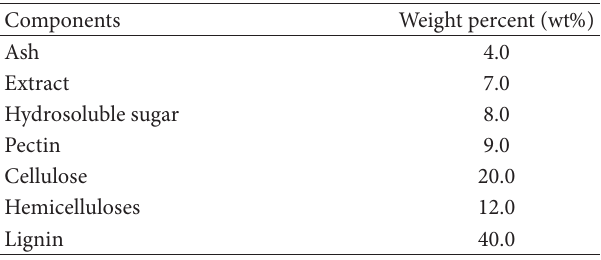
T 1: Chemical composition of oil palm shells. Components